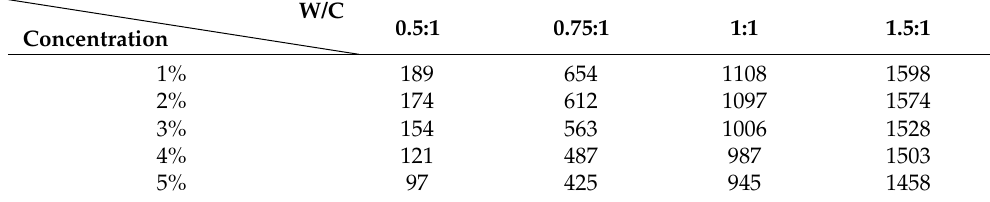
Table 1. Gel times of double slurries with different concentrations and water–cement ratios. W/C Concentration